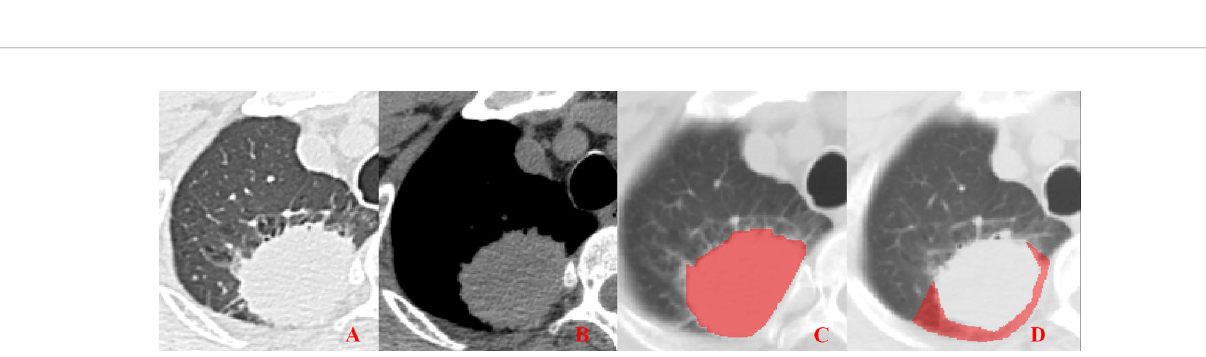
FIGURE 4 | Pleural involvement of Type III. (A, B) Tumor attached to the pleura with a broad base observed in both the lung window and mediastinal window images. (C, D) ROI delineation of the primary tumor and nearby